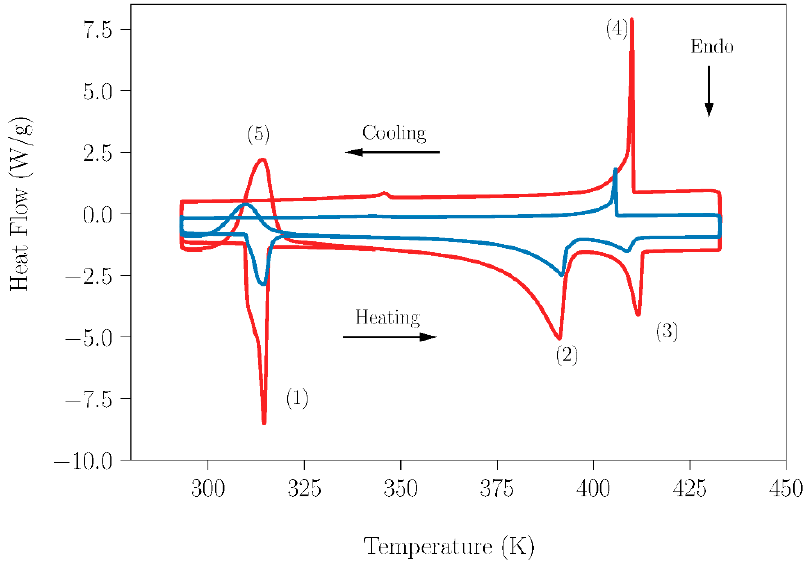
Figure 6. DSC measurements of NPG 0.515 TRIS 0.485 peritectic samples in the temperature range 293–433 K. Blue lines correspond to the sample S Ar (prepared and handled under dry conditions). Red lines correspond to the sample S Lab (prepared and handled under laboratory conditions). The heating/cooling rate used in this experiment was 1 K · min − 1 . Peak labels: (1) Eutectoid reaction 1; (2) Eutectoid reaction 2; (3) Peritectic melting; (4) Peritectic solidification and (5) Recrystallization process. Table 3. Temperature and enthalpy values associated with each identified transition for the peritectic samples NPG 0.515 TRIS 0.485 ; S Lab (without special handling, preparation, and storage) and S Ar (with special handling, preparation, and storage).